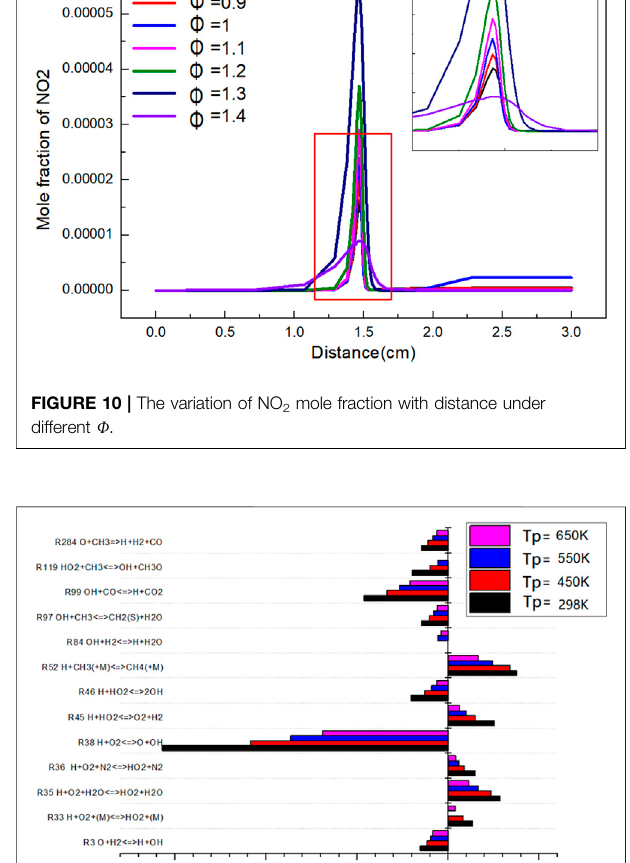
Figure 11 . When the preheating temperature changes, the elementary reactions show roughly the same rule. The